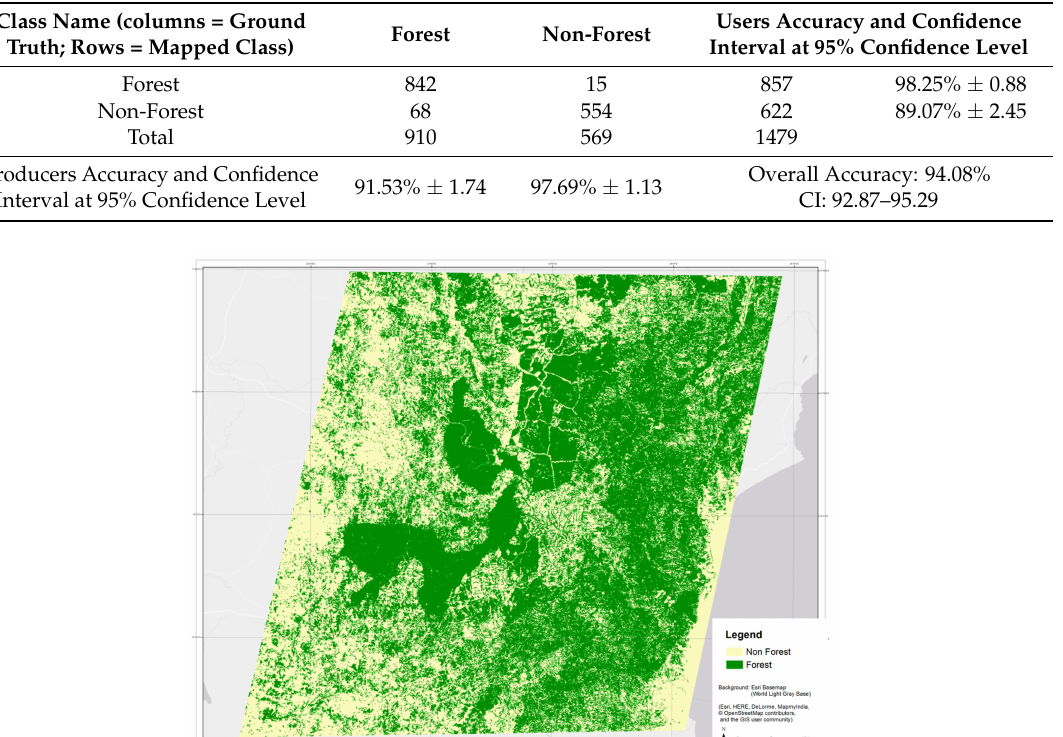
Table 6. Confusion matrix of the final FNF map of Malawi after plausibility check.